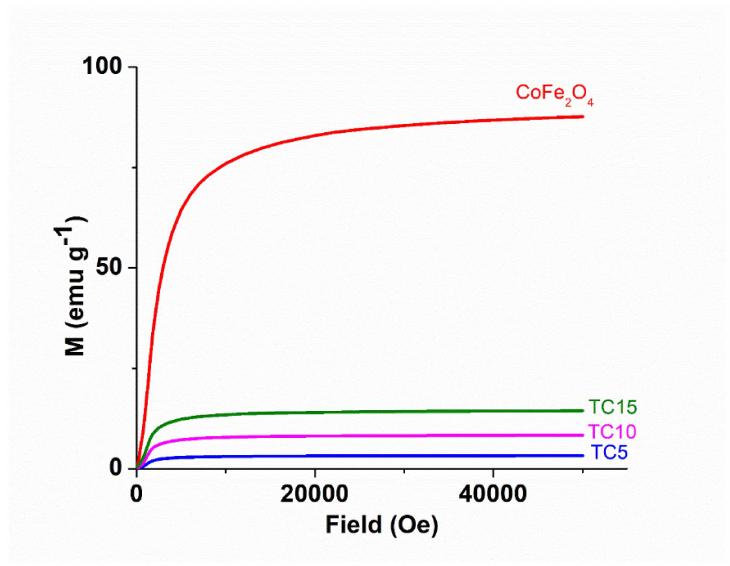
Figure 9. Magnetization curves of CoFe 2 O 4 and the TCX composites.